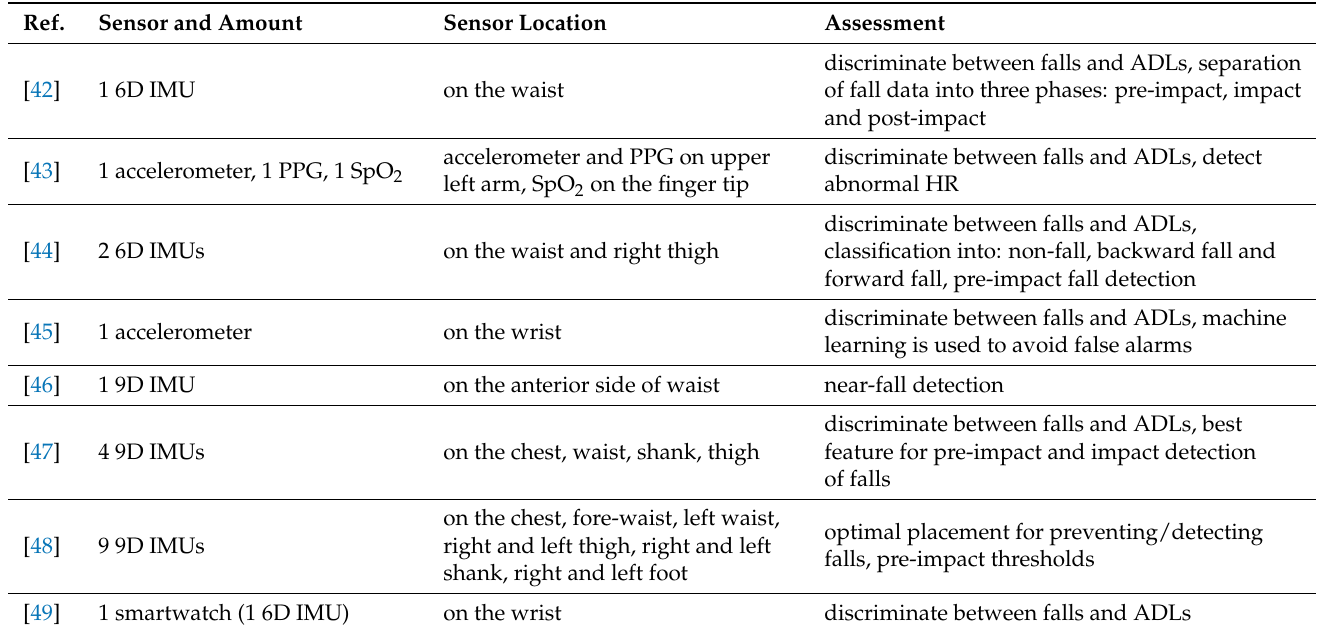
Table 4. Study characteristics for studies on fall